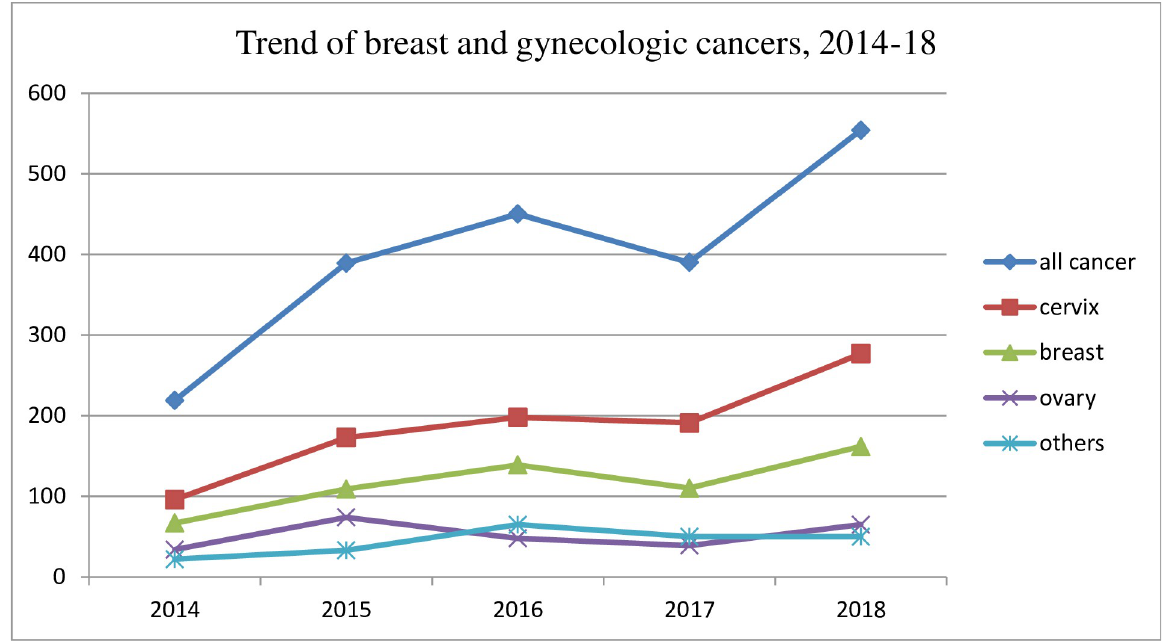
Fig 4. Trend of breast and gynecologic cancers, 2014–18,